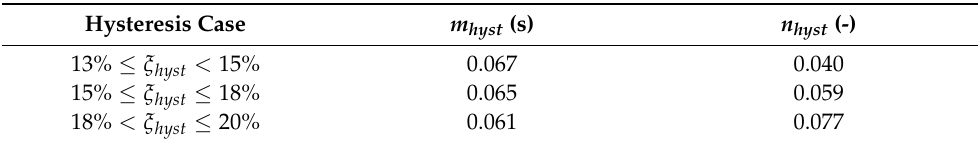
Table 1. Calibrated parameters for the proposed OSM equations.